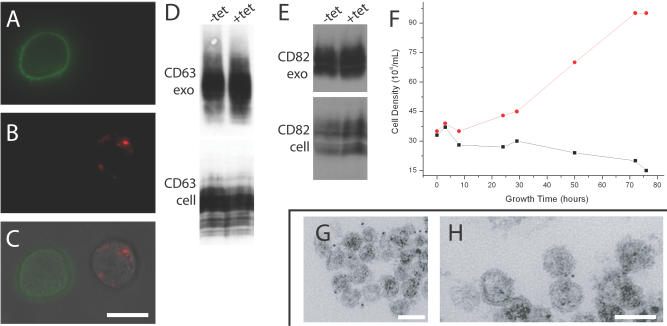
Impairing Class E VPS Function Does Not Block Exosome Budding(A–C) Fluorescence micrographs of T-rex/DsRED-VPS4B/K180Q cells that had been (left cell) grown in the absence of tetracycline, labeled with the green plasma membrane dye PKH-67, and fixed, or (right cell) incubated overnight with tetracycline and fixed. Following fixation, the two cell populations were mixed and images were collected for (A) PKH-67 fluorescence, (B) DsRED-VPS4B/K180Q fluorescence, and (C) phase contrast, which was merged with the two fluorescent images. Bar indicates 10 μm.(D and E) Immunoblots of exosome (exo) and cell lysates generated from T-rex/DsRED-VPS4B/K180Q cells incubated with (+tet) or without (−tet) tetracycline overnight, blotted with antibodies specific for (D) CD63 and (E) CD82.(F) Growth curve (cell density [104 cells/ml] vs. time in hours) of T-rex/DsRED-VPS4B/K180Q cells in the (red circles) absence or (black squares) presence of tetracycline.(G and H) Immunoelectron micrographs of exosomes secreted by K562 cells expressing DsRED-VPS4B/K180Q, labeled with immunogold for the exosomal protein CD63. Bar indicates 100 nm.